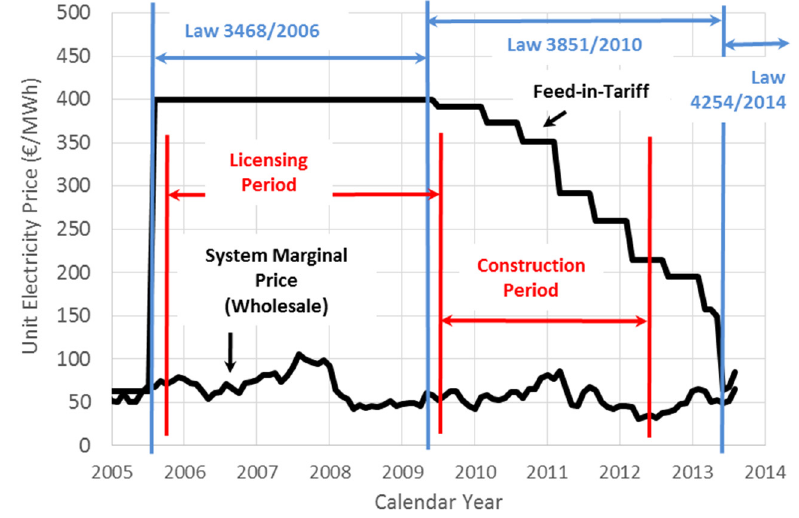
Figure 2. Evolution of feed-in-tariffs. Data from Hellenic Electricity Market Operator